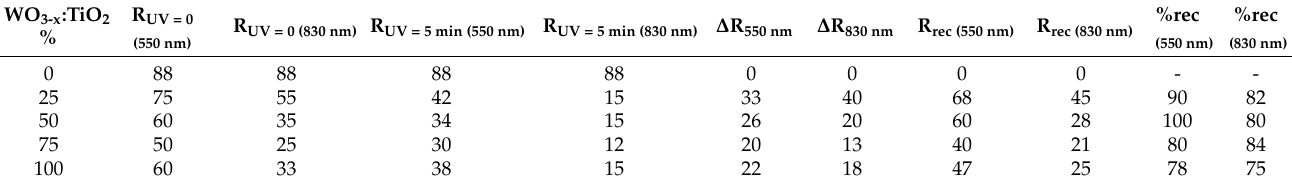
Table 1. WO 3-x :TiO 2 % related to different WO 3-x percentage content into NCs mixture for textile coating; R UV = 0 (550 nm) and R UV = 0 (830 nm) Reflectance percentage at 550 nm and 830 nm, respec- tively, of NC-functionalized samples with no UV exposure; R UV = 5 min (550 nm) and R UV = 5 min (830 nm) Reflectance percentage at 550 nm and 830 nm, respectively, of NC-functionalized samples with 5 min of UV exposure; ∆ R 550 nm and ∆ R 830 nm related to the difference between R UV = 5 min (550 nm) – R UV = 0 (550 nm) and R UV = 5 min (830 nm) –R UV = 0 (830 nm), respectively; R rec (550 nm) and R rec (830 nm) re- lated to recovered reflectance percentage at 550 nm and 830 nm, respectively, of air-exposed sam- ples kept 150 min in the dark; %rec (550 nm) and %rec (830 nm) related to percentage R rec (550 nm) and R rec (830 nm) compared to initial R UV = 0 (550 nm) and R UV = 0 (830 nm)